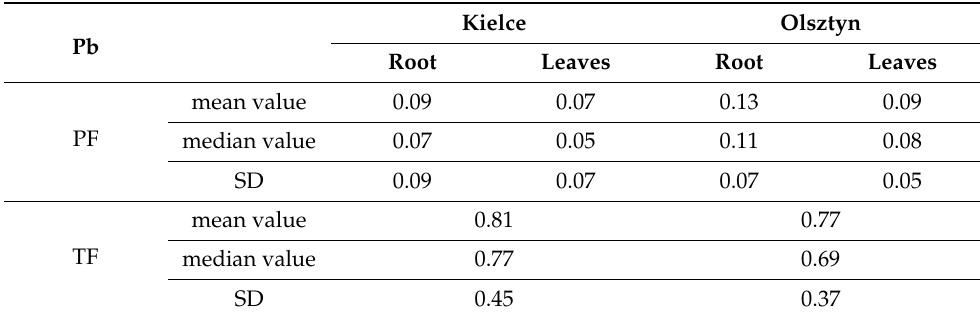
Table 9. Phytoaccumulation factor and translocation factor of lead for the common dandelion’s roots and leaves from Kielce and